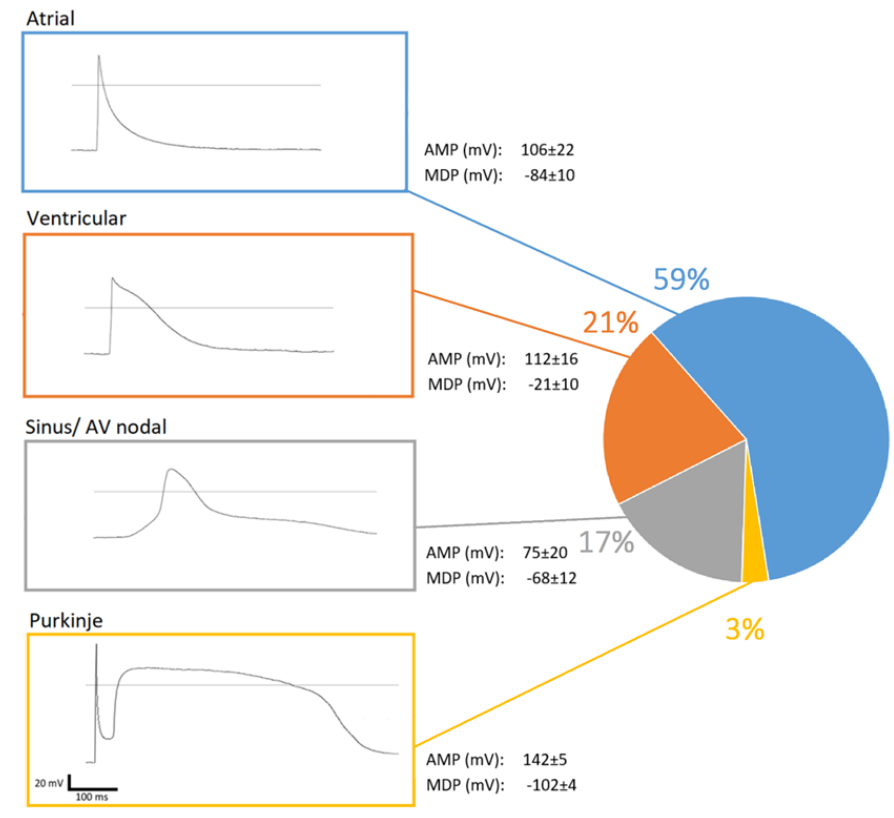
Figure 4. hPSC-CMC are composed of all major CM types. Examples of recordings using the patch- clamp technique in the whole-cell configuration (respective boxes) show the characteristic action potential kinetics by which the different CM types were assigned. Assigned voltages of the amplitude of the action potential (AMP) and minimum diastolic membrane potential (MDP) are the mean values of all measurements of the respective cell type. Percentages of characteristic cardiac cell types are shown in the pie chart (n = 33). AV =